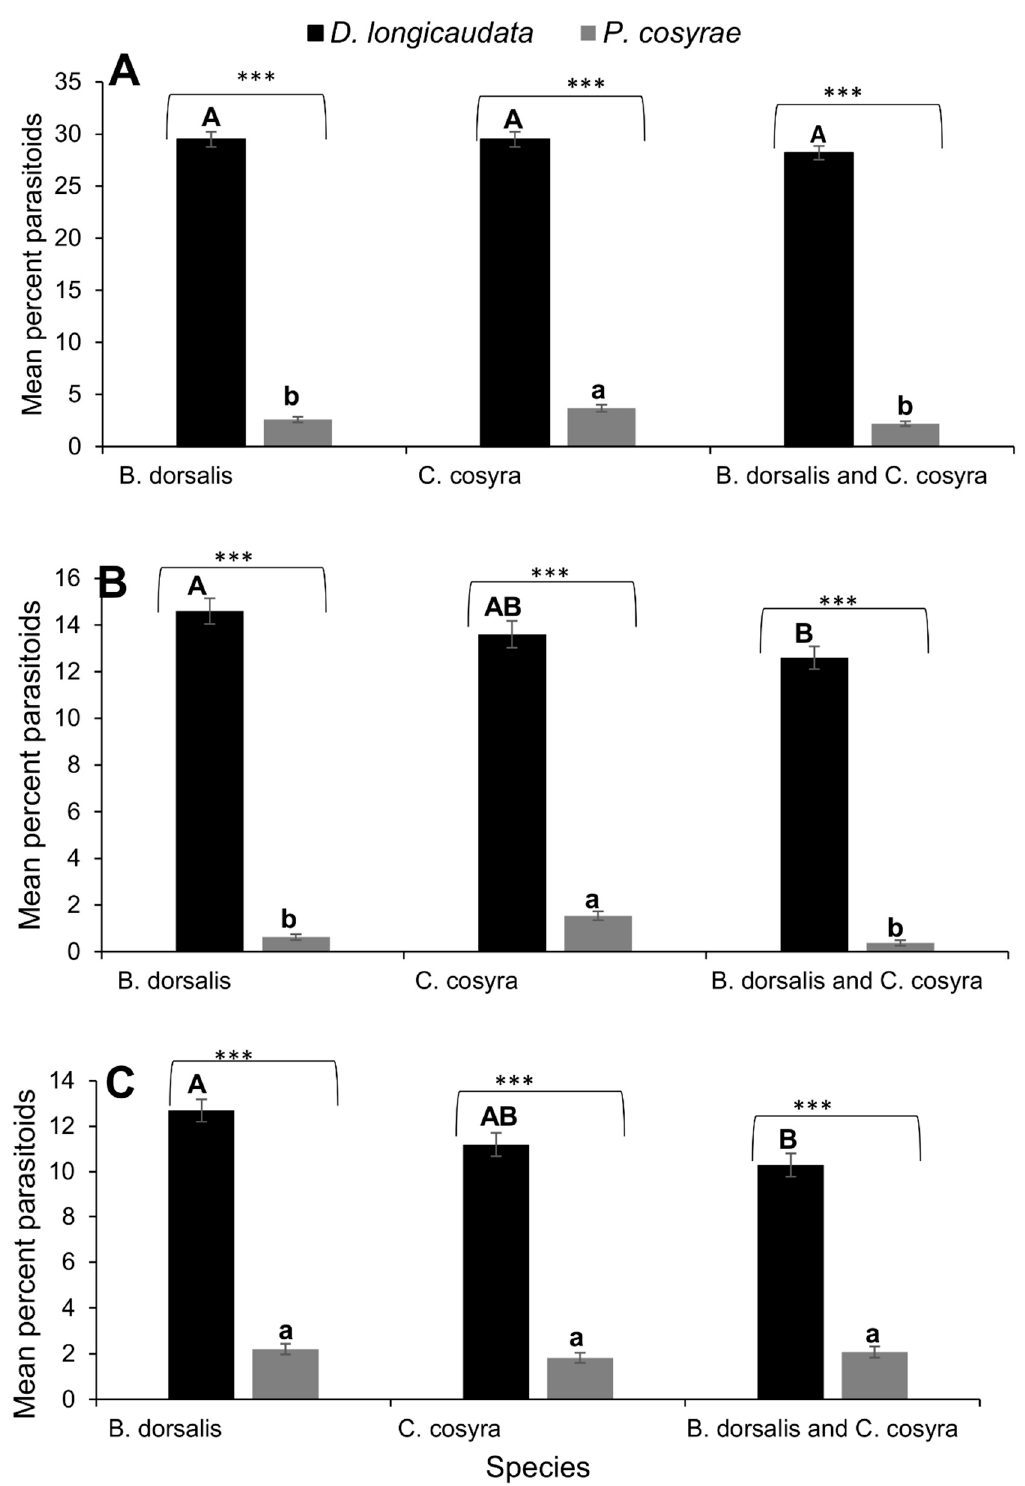
Figure 2. Mean percent ( ± SE) of parasitoids Diachasmimorpha longicaudata and Psyttalia cosyrae activities with ( A ) searching, ( B ) probing and ( C ) ovipositing over a period of 180 min on Bactrocera dorsalis and Ceratitis cosyra as hosts. For each parameter, means superscripted by the same capital or small letters do not differ significantly (repeated measure ANOVA at α = 0.05). *** = p < 0.0001 for t - test.